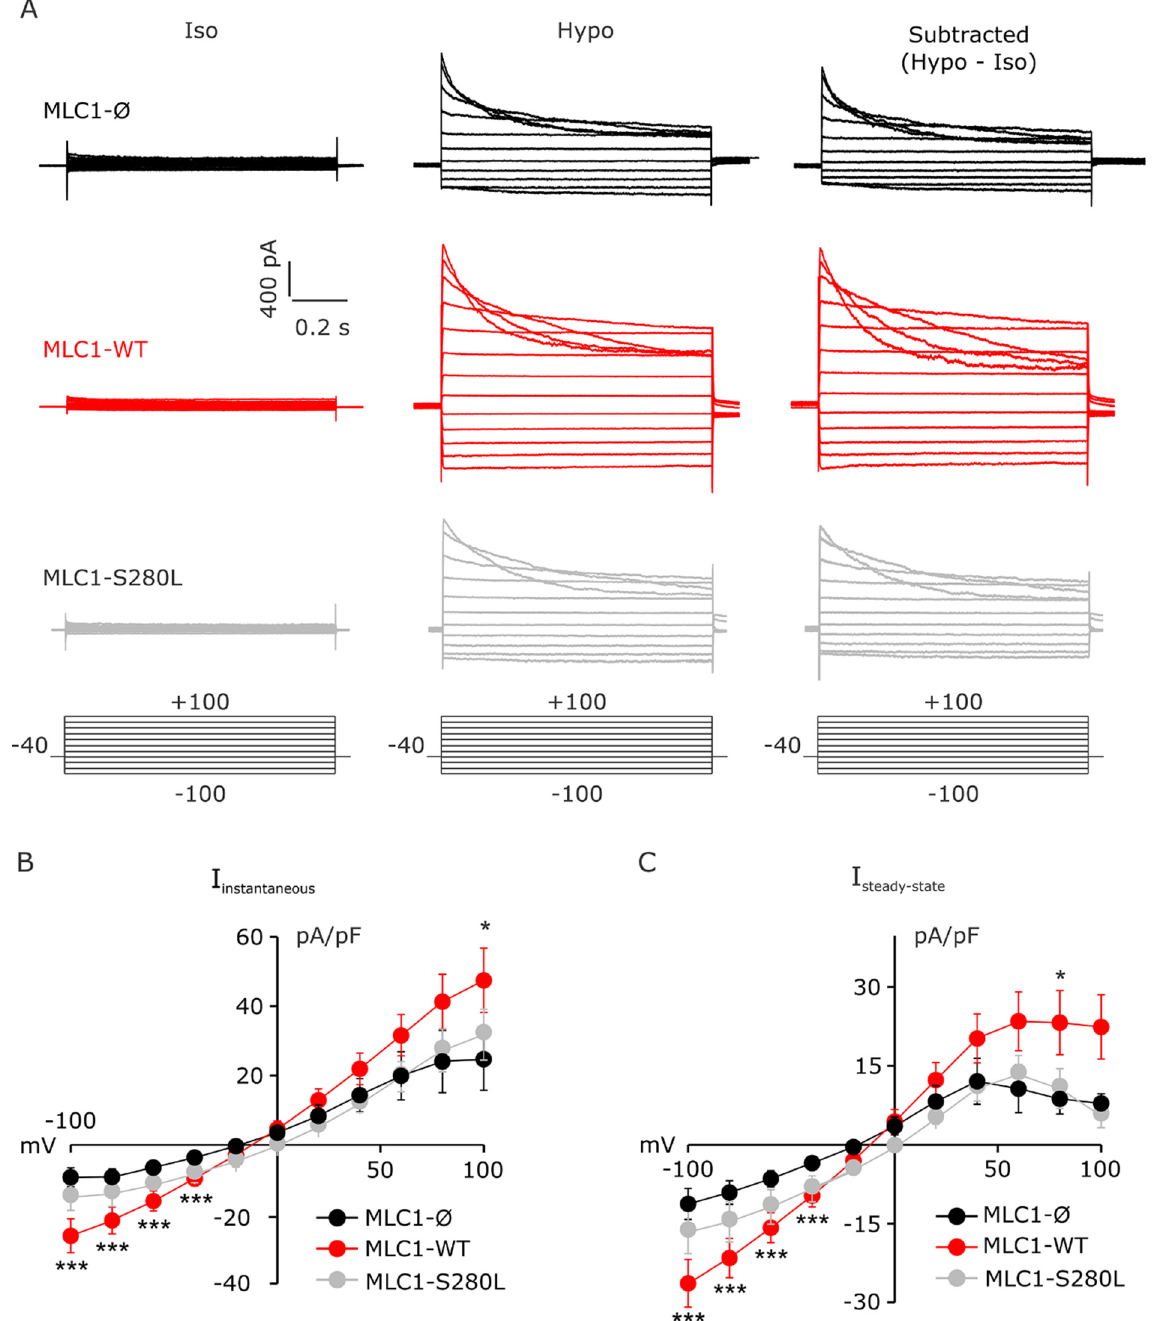
Figure 4. MLC1 upregulates ICl, swell currents in U251 astrocytoma cells. ( A ) Representative I–V relationships recorded from − 100 to +100 mV pulses (Delta 20 mV, holding potential − 40 mV, duration 1 s) in U251 cells infected with an empty vector (Ø) ( top ), expressing MLC1-WT ( middle ) or MLC1-S280L mutant ( bottom ) in control condition ( left ), following application of hyposmotic solution ( center ) and after digital subtraction (Hypo-Iso, right ). ( B , C ) Mean I–V relationships of instantaneous and steady state current obtained in MLC1-Ø (black; n = 6), MLC1-WT (red; n = 9), and MLC1-S280L cells (grey; n = 6) after digital subtraction (Hypo-Iso) (mean ± SEM; * p < 0.05; *** p < 0.001).